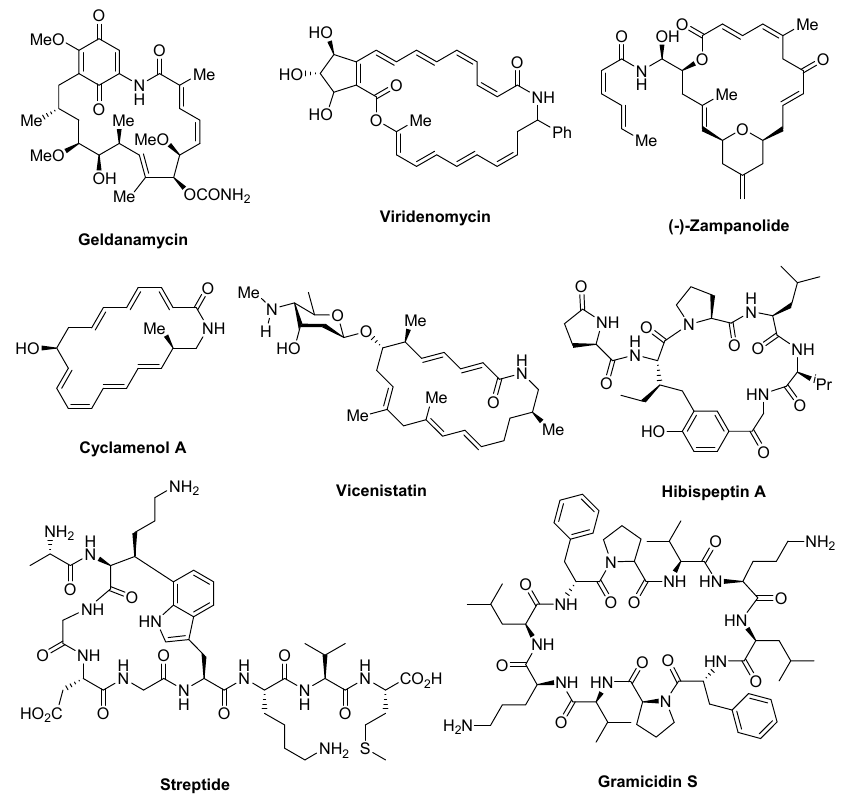
Figure 1. Representative examples of bioactive macrocyclic natural products.